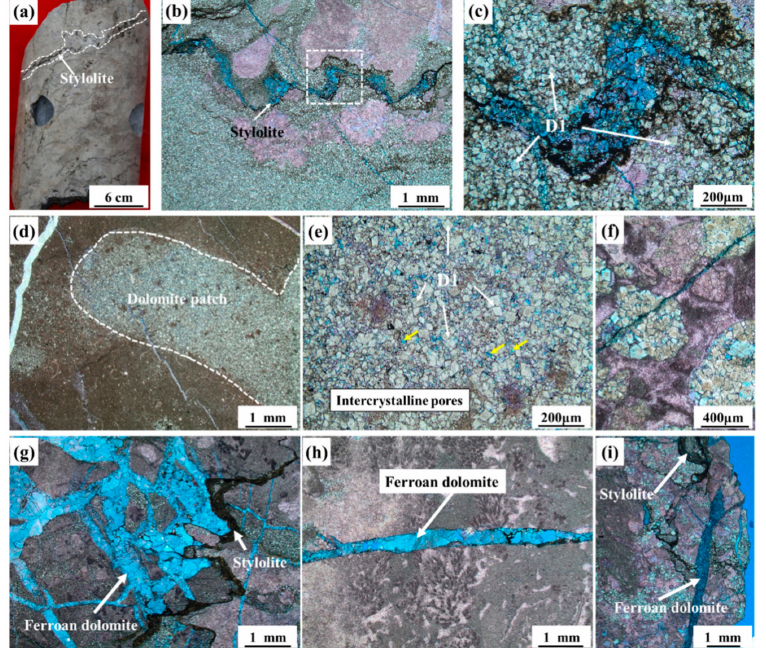
Figure 3. Petrological characteristics of the powder-fine dolomite and dolomite cements (D1). ( a ) Lower angle stylolite in the core, Well Bg26 2801.9 m, Zhangxia formation; ( b ) the character- istics of the powder-to-fine-crystalline dolomite cements (D1) around the stylolite. Stylolite is filled with black organic matter, Well Bg26 2801.9 m, Zhangxia formation; ( c ) local amplification of b; ( d ) the characteristics of the dolomite patch, the outside of the dolomite patch is argillaceous limestone, Well Bg26 2515.6 m, Yeli-Liangjiashan formation; ( e ) local amplification of d, intercrystalline pores (yellow arrow); ( f ) the characteristics of the powder-to-fine-crystalline dolomite cements (D1) interior of the oolite, Well Bg26 2790.5 m, Zhangxia formation; ( g ) the petrological characteristics of the fine-crystalline ferroan dolomite cement (D2) and the relationship between the fracture and stylolite, Well Bg26 2801.9 m, Zhangxia formation; ( h ) algal limestone. The petrological characteristics of the fine-crystalline ferroan dolomite cement (D2), Well Bg26 2803.5 m, Zhangxia formation; ( i ) dolomitic bioclastic limestone. The petrological characteristics of the fine-crystalline ferroan dolomite cement (D2), Well Bg26 2803.7 m, Zhangxia